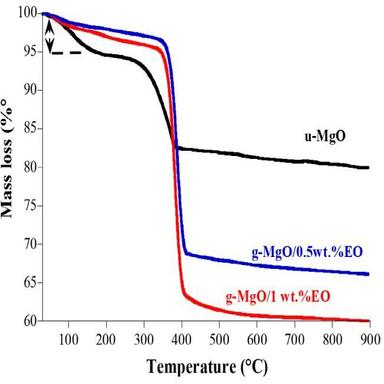
TG curves of grafted nanoparticles g-MgO-EO compared to u-MgO.